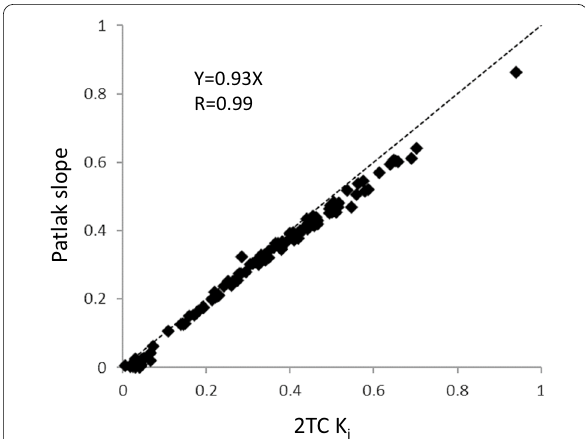
cer cerebellum, cau caudate, put putamen, tha thalamus, fro frontal cortex, tem temporal cortex, hip hippocampus, SD standard deviation, 2TC two-tissue compartment model